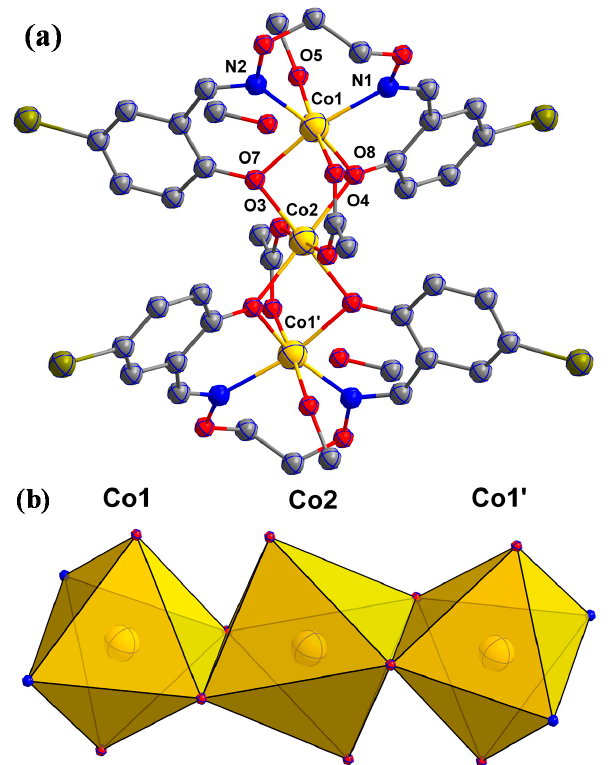
Figure 4. ( a ) The crystal structure of the Co(II) complex (hydrogen atoms are omitted for clarity, and the atomic symbol only marked the symmetrical part); ( b ) Coordination polyhedral map of Co(II) atoms. Table 2. Bond lengths (Å) and angles ( ◦ ) of the Co(II)